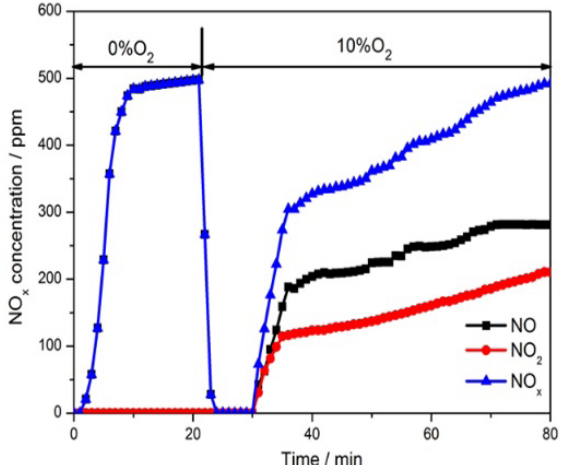
adsorption amount、NO X